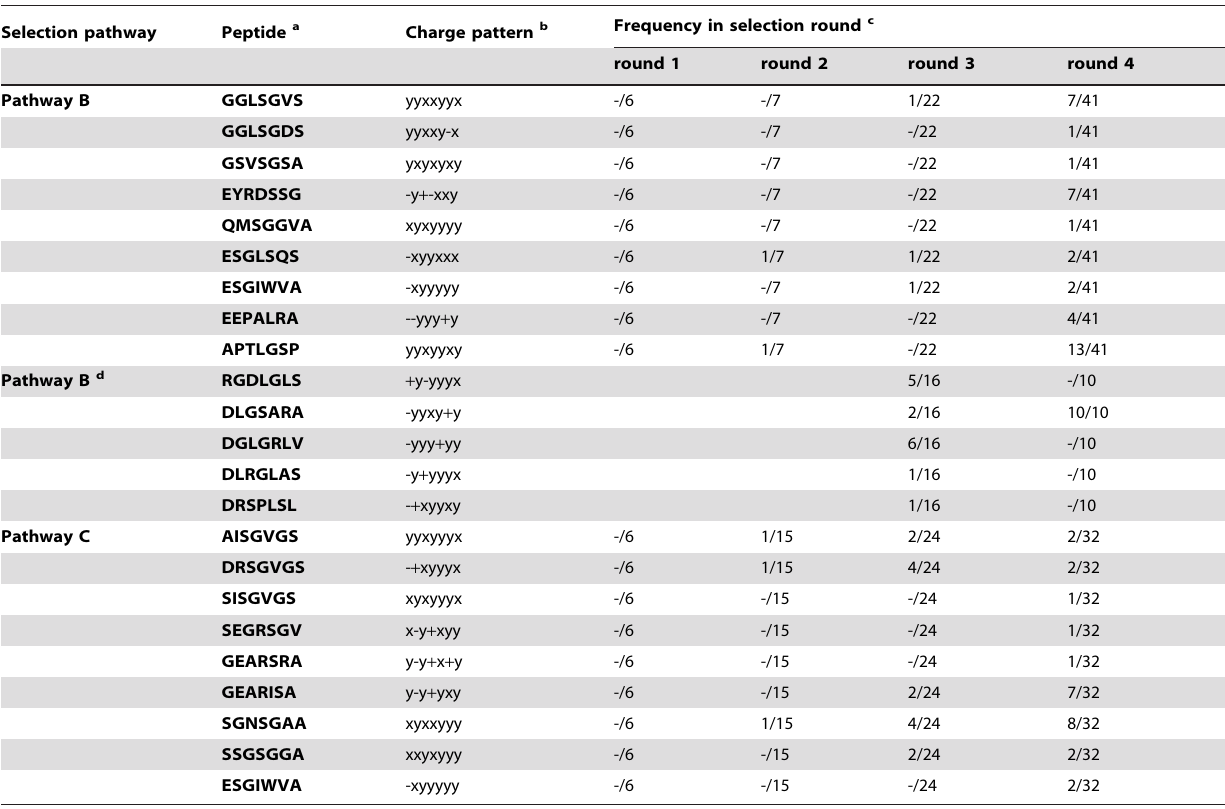
Selection pathway Peptide